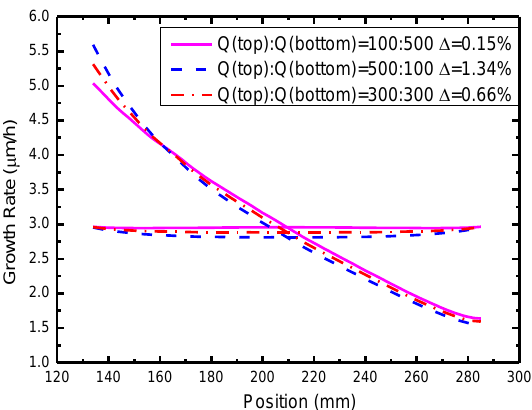
Figure 5. Simulated results of the growth rate profiles for the various top to bottom AsH 3 ratios as functions of satellite radius. P = 5 × 10 3 Pa, T growth = 700 ◦ C, carrier gas flow rate Q H2 = 37 slm, total AsH 3 flow rate Q AsH3 = 600 sccm.